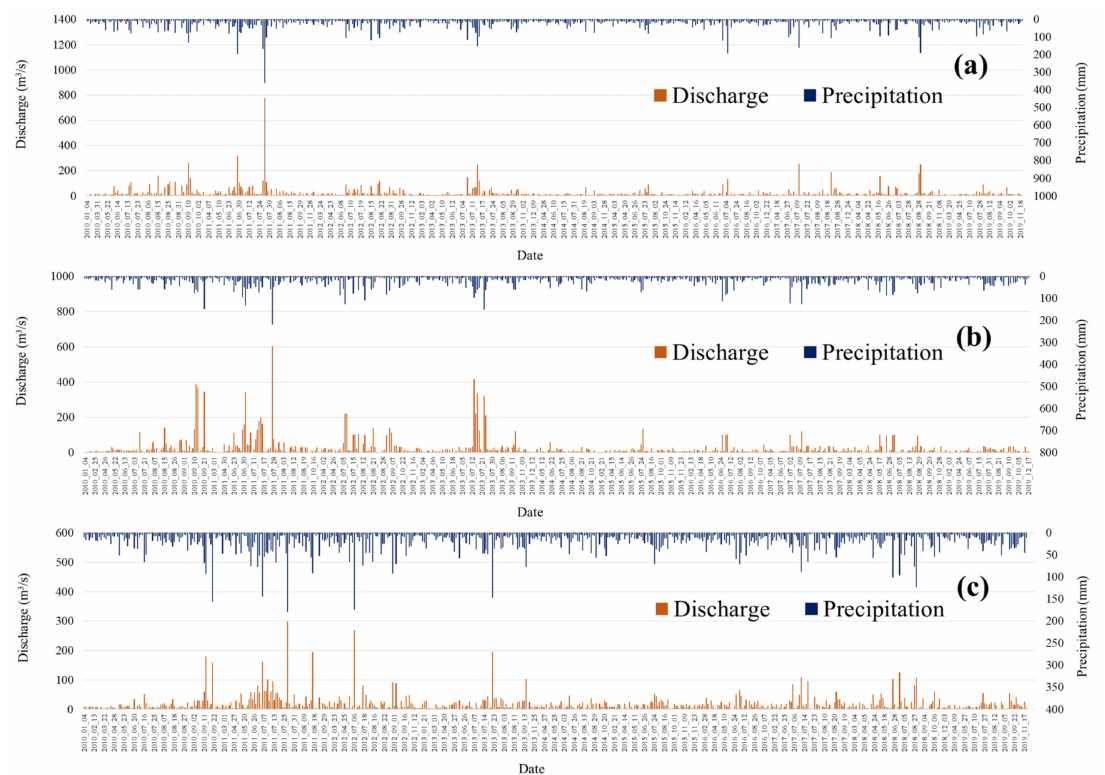
Figure 2. Variations in the discharge and precipitation according to the date of the rainfall event during the study period: ( a ) JJ watershed; ( b ) HC watershed; ( c ) BH